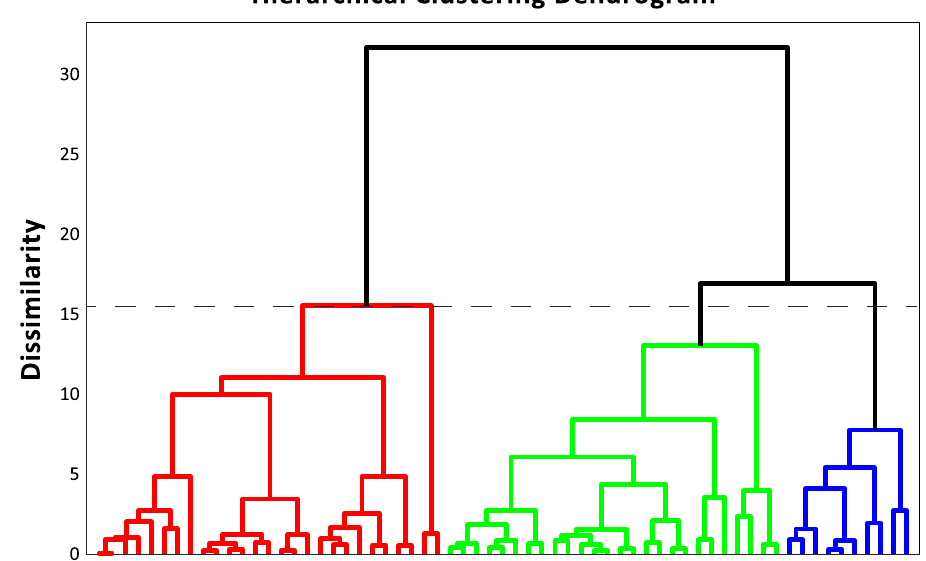
Figure 1. Psychological phenotypic clustering in individuals seeking treatment for anxiety. Dendrogram illustrating the hierarchical agglomerative clustering analysis of questionnaire items from the GAD-7, PSWQ, FFMQ Non-Reactivity Scale, and MAIA questionnaires in Study 1. Different clusters are illustrated in distinct colors (red, green or blue) on the dendrogram (dashed line indicates stopping rule according to the maximal linkage